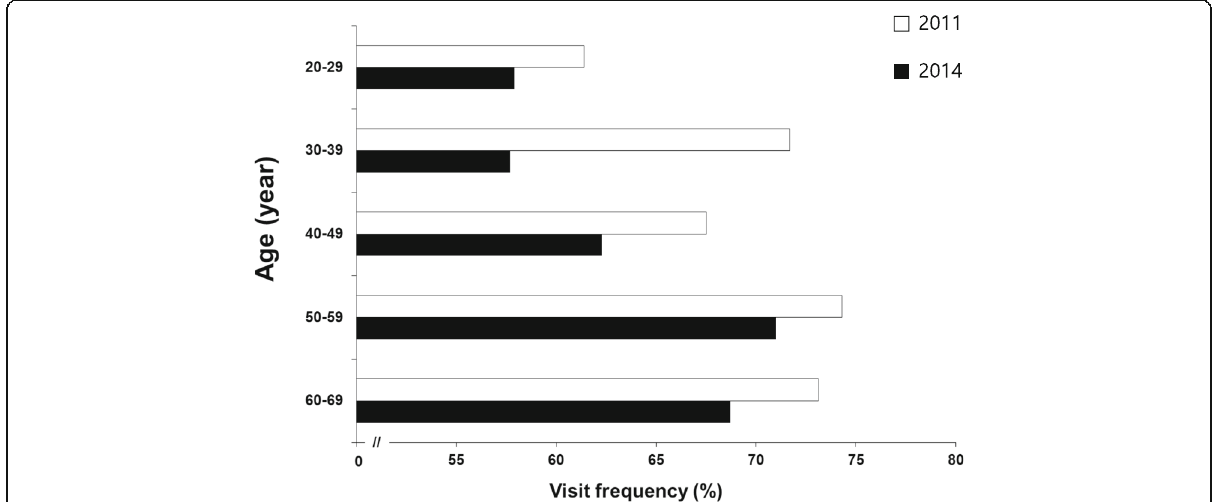
Fig. 2 Reduction in TK clinic visits by age between 2011 and 2014. In 2014, there were larger decreases in visit frequency among participants their 20s and 30s than in the other age groups compared to the 2011 survey. The 2011 survey data were obtained from Woo et al. [11]